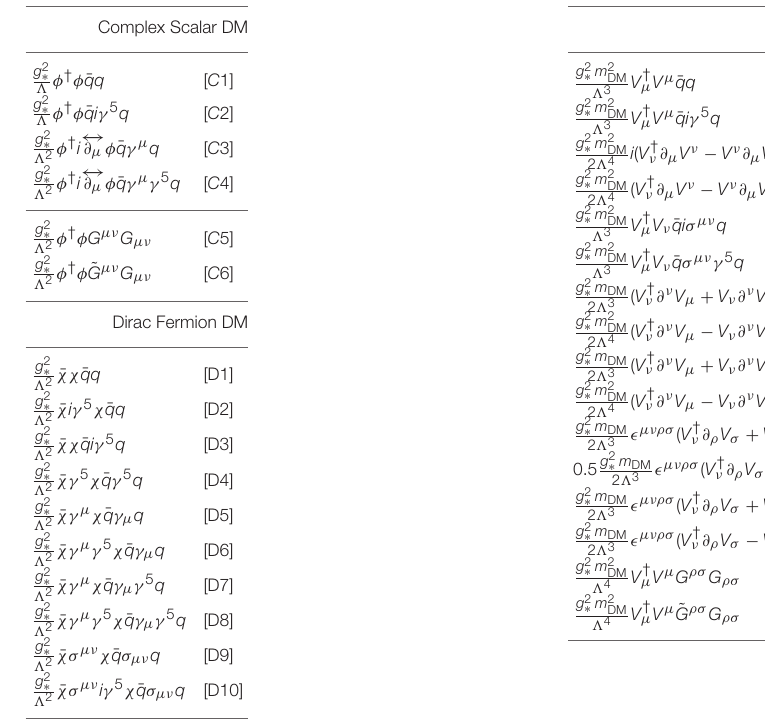
TABLE 1 | Minimal basis of dimension 5 and 6 operators for complex scalar DM ( φ ), Dirac fermion DM ( χ ) or complex vector DM ( V µ ) interacting with SM quarks ( q ) or gluons.